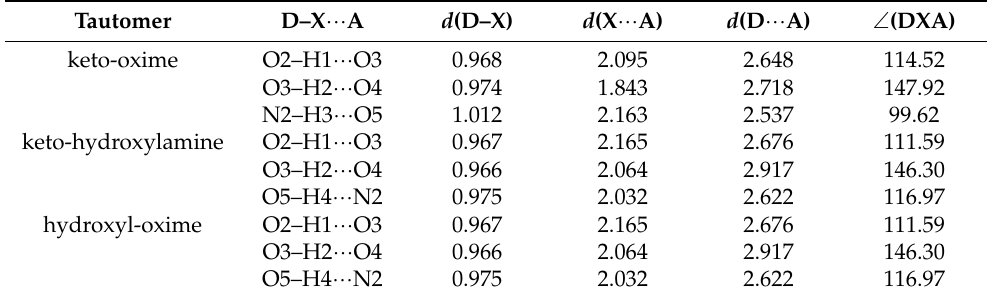
Table 3. Hydrogen bond lengths (Å) and angles ( ◦ ) in the optimized structures of the keto-oxime, keto- hydroxylamine and hydroxyl-oxime tautomers of molnupiravir, obtained by using the DFT/B3LYP/6- 311++G(d,p) method.